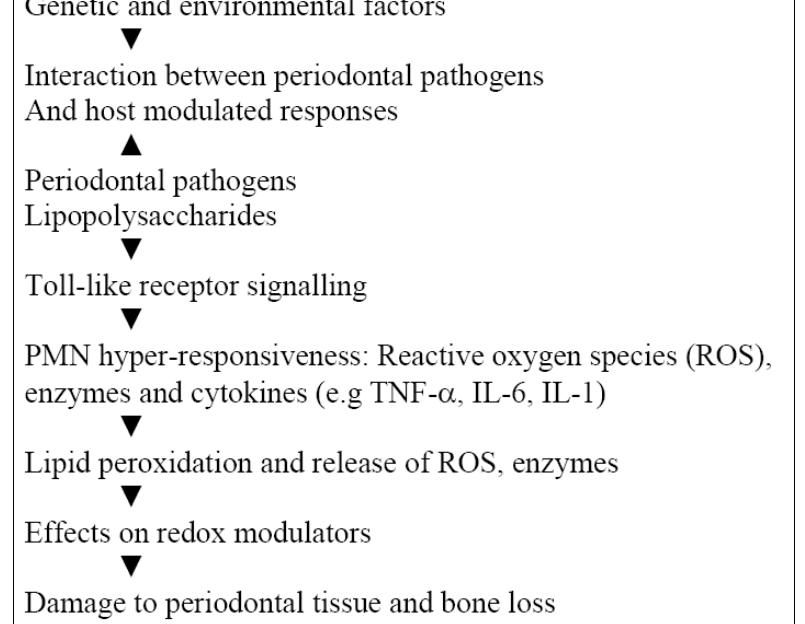
Figure 1. Role of host modulated inflammatory responses in destructive periodontal